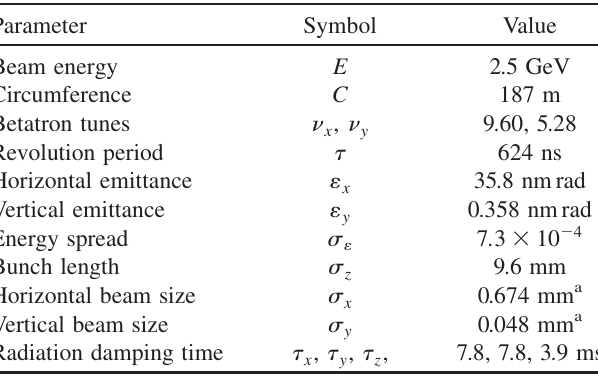
TABLE I. Main parameters of the PF ring.